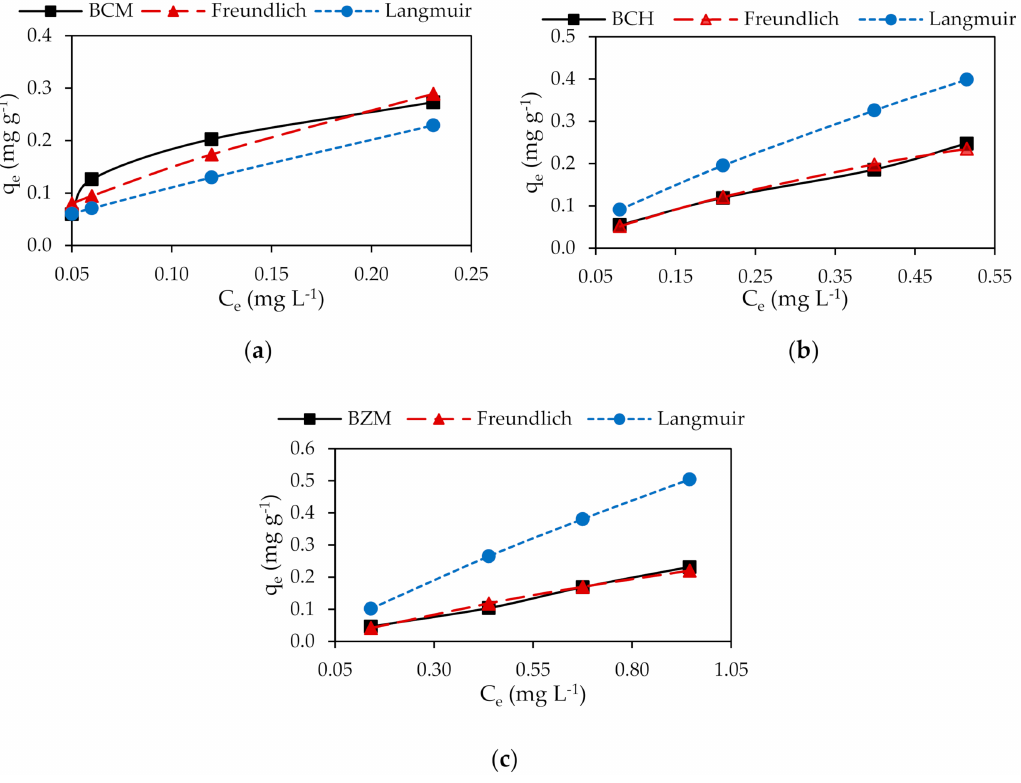
Figure 7. Adsorption Cd 2 + isotherms: ( a ) BCM, ( b ) BCH and ( c )